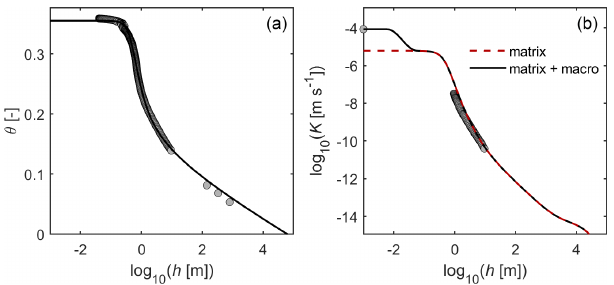
Figure 10. Application of the interpolation scheme given by Eq. (24) to the data set shown in Fig. 1a and b. The FX-PDI model was fitted to the water retention data and K(h) was predicted from dryness to h = 0 .